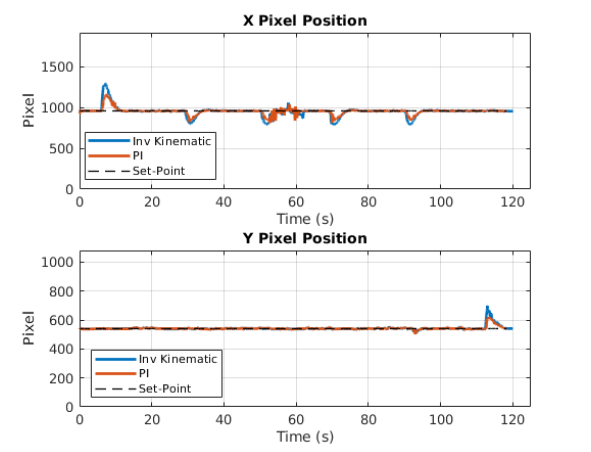
Figure 10. Pixel comparation of different track controllers at Gazebo environment.